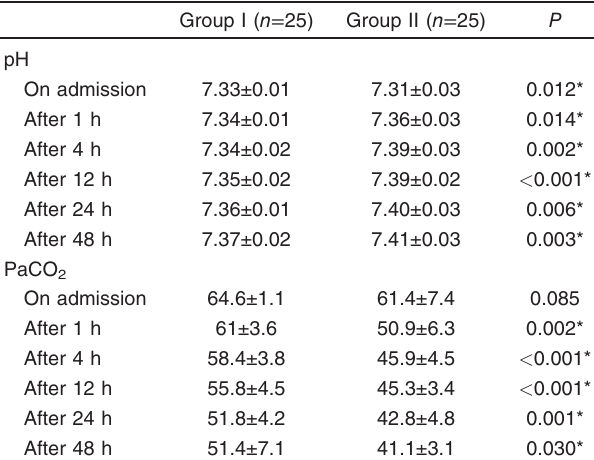
Table 8 Comparison between baseline and follow-up pH and PaCO 2 of successful cases in both groups at different studied periods ( n =